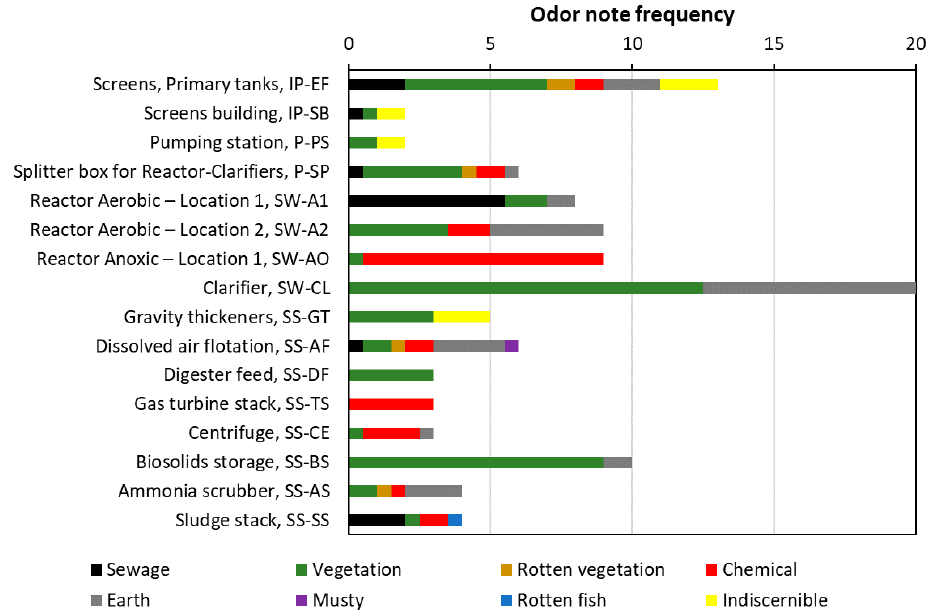
Figure 5. Odor notes assigned by the sensory panel. A frequency of 1 is used if only one odor note was assigned, while 0.5 is assigned to each note if two notes were assigned to a single sample. The frequency will always equal 1 per sampling occasion.